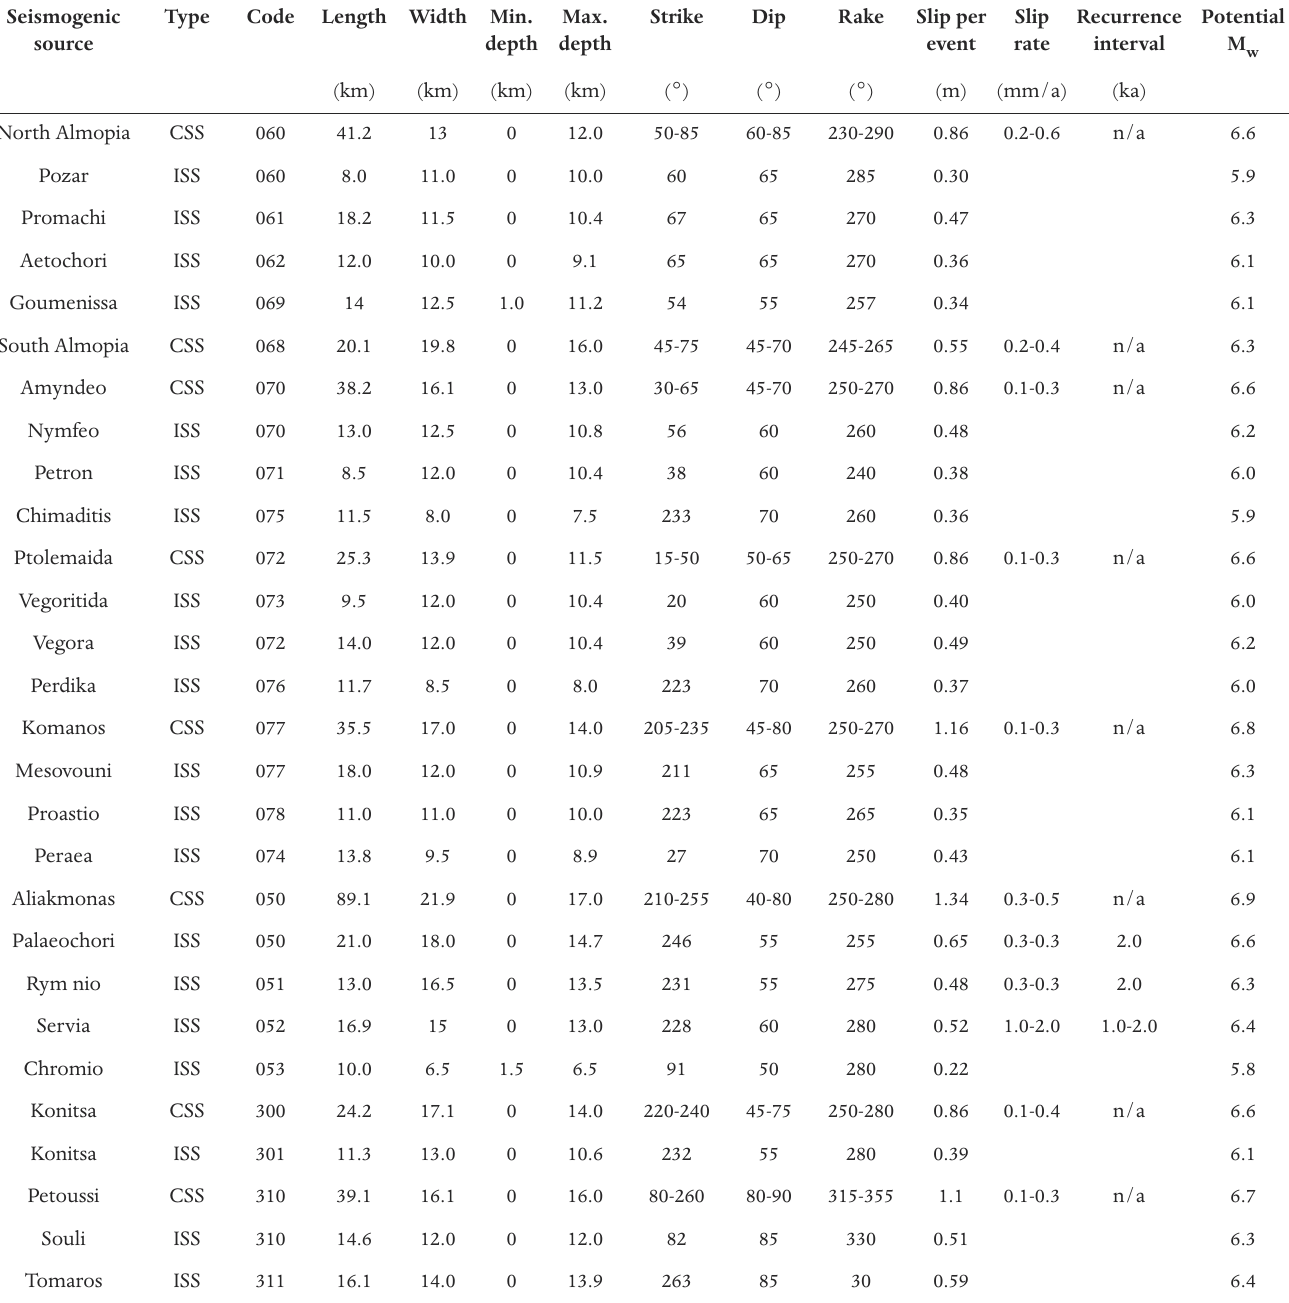
Table 4. Seismotectonic parameters of the CSSs and ISSs included in the 'anti-Hellenides' fault system (see Figure 5). CSS, composite seismogenic source; ISS, individual seismogenic source; Code, identification number within the database; n/a, not